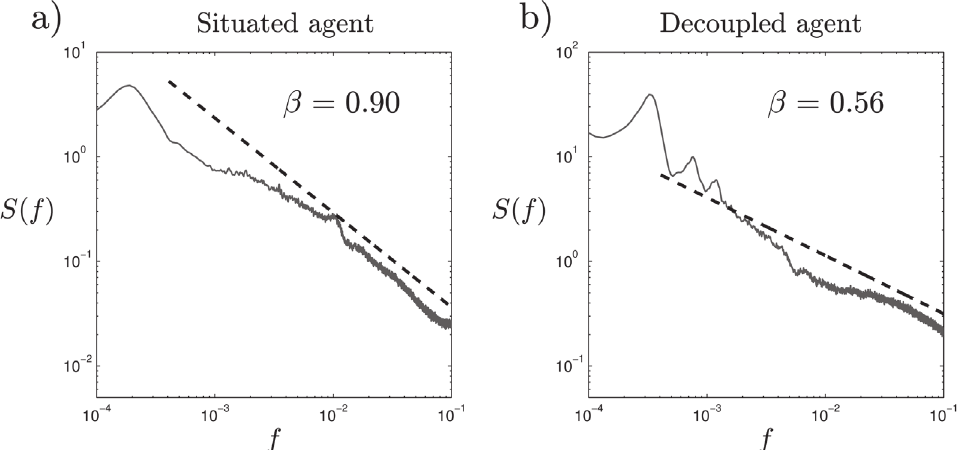
Fig 7. Result of the discrete Fourier transform. We observe the differences between the situated and decoupled agent and how deviations from linearity in the decoupled agent are much more noticeable in DFT analysis than in DFA